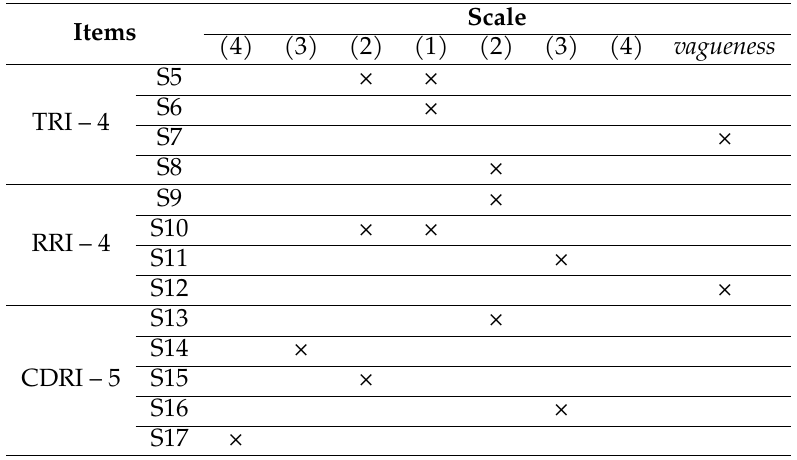
Table 4: Answers from an employee to the TRI – 4 , RRI – 4 , and CDRI –